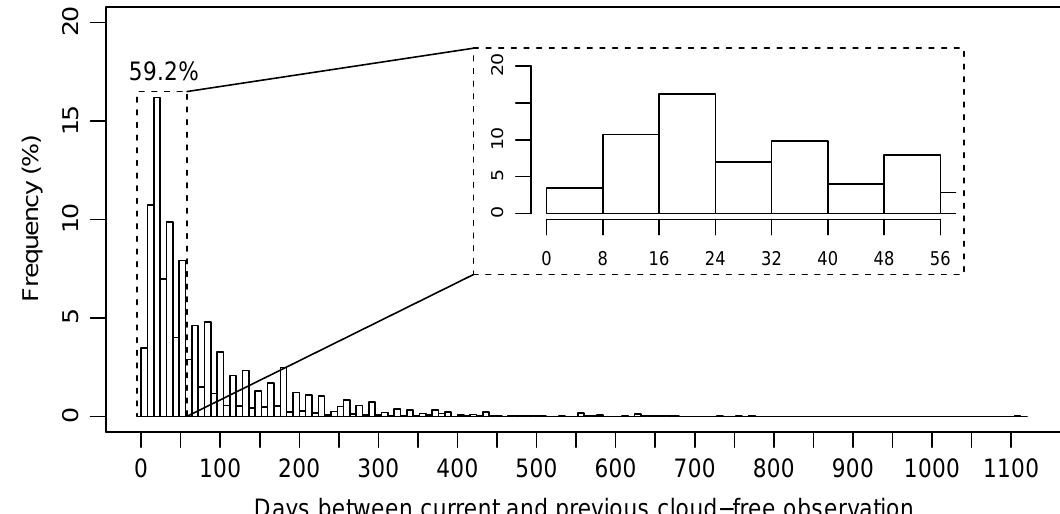
Figure 4. Distribution of the time separation between a cloud-free observation and the previous cloud-free observation in the Landsat time series (LTS). Calculated for the whole period (since 1984) with combined data from TM, ETM+, and OLI, from the LTS of 435 reference sample pixels assessed in Section 2.4. The histogram bin widths are set as 0–7, 8–15, 16–23, ... , 1112–1119, and the percentages denote the percentage in each bin. The graph was made using R software